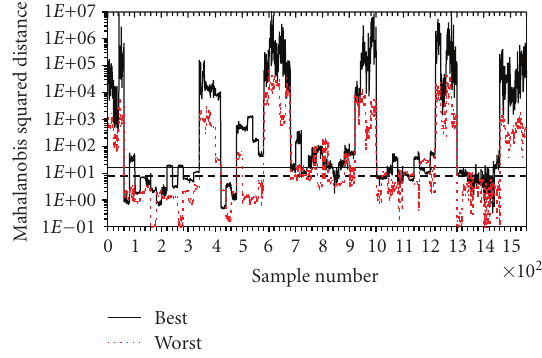
Figure 6: Test 1. Mahalanobis squared distance as a function of the sample number associated with the filtering combination that maximizes (best) and minimizes (worst) the detection of transverse surface defects probed using the central sensors pair and high- frequency